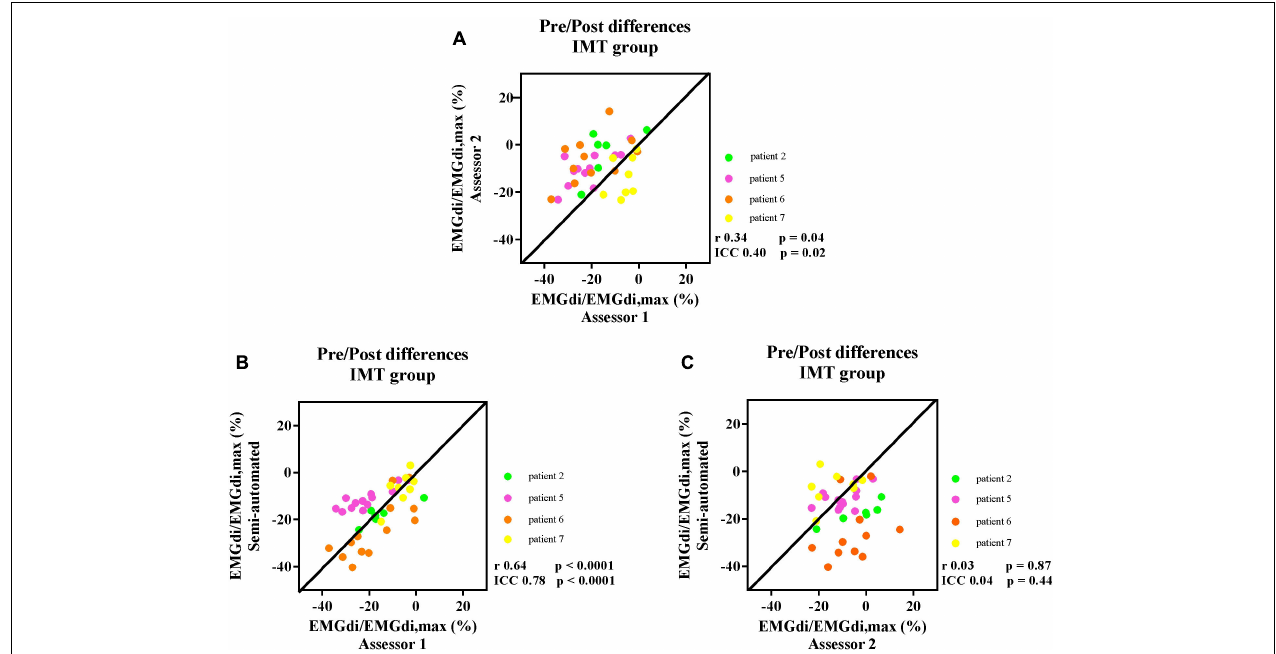
FIGURE 7 | The correlation between the pre/post difference in four participants EMGdi/EMGdiMax% calculated from the manual method by two assessors (A) ; the semi-automated method and the manual method by assessor 1 (B) ; the semi-automated method and the manual method by assessor 2 (C) . Line of identity, linear regression coefficients and intra-class correlation coefficients (ICC) and significances are presented in each figure. Each of the data points represents the pre/post differences of diaphragm EMG activation (EMGdi/EMGdiMax%) pre and post the intervention of each patient in every minute during CWR cycling test.